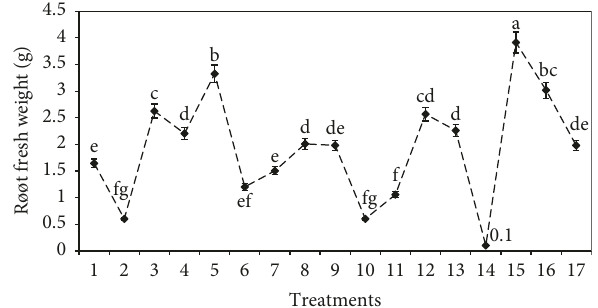
Figure 8: Impact of biosorbed water by various biosorbents (or- ange peels, pomegranate peels, and peanut peels) on root fresh weight of mung bean after 7 days of seed germination. T1, negative control; T2, 50mg kg − 1 ; T3, pomegranate peel biosorbed water +50mg kg − 1 ; T4, peanut peel biosorbed water +50mg kg − 1 ; T5, orange peel biosorbed water +50mg kg − 1 ; T6, 100mg kg − 1 ; T7,